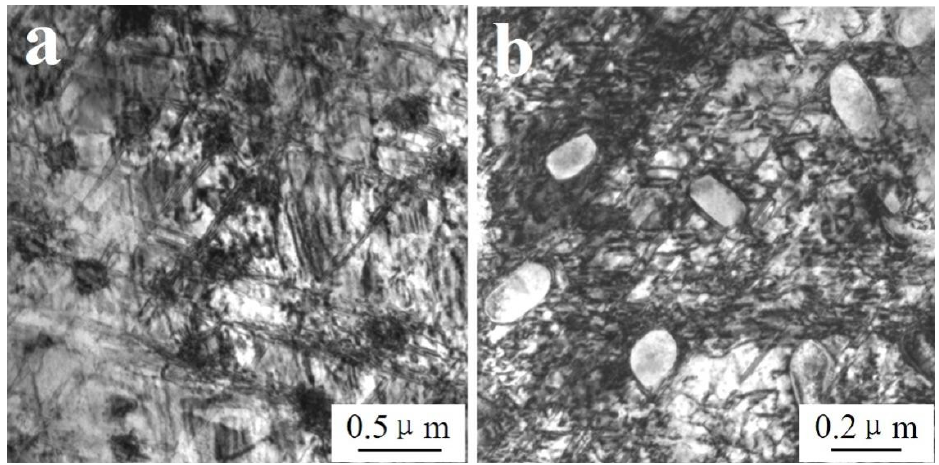
Figure 4. Stacking faults in the area containing lots of precipitates in matrix of W f /Cu 82 Al 10 Fe 4 Ni 4 composites after dynamic compression at high temperatures: ( a ) Al 3 Ni phase and ( b ) (Fe, Ni)